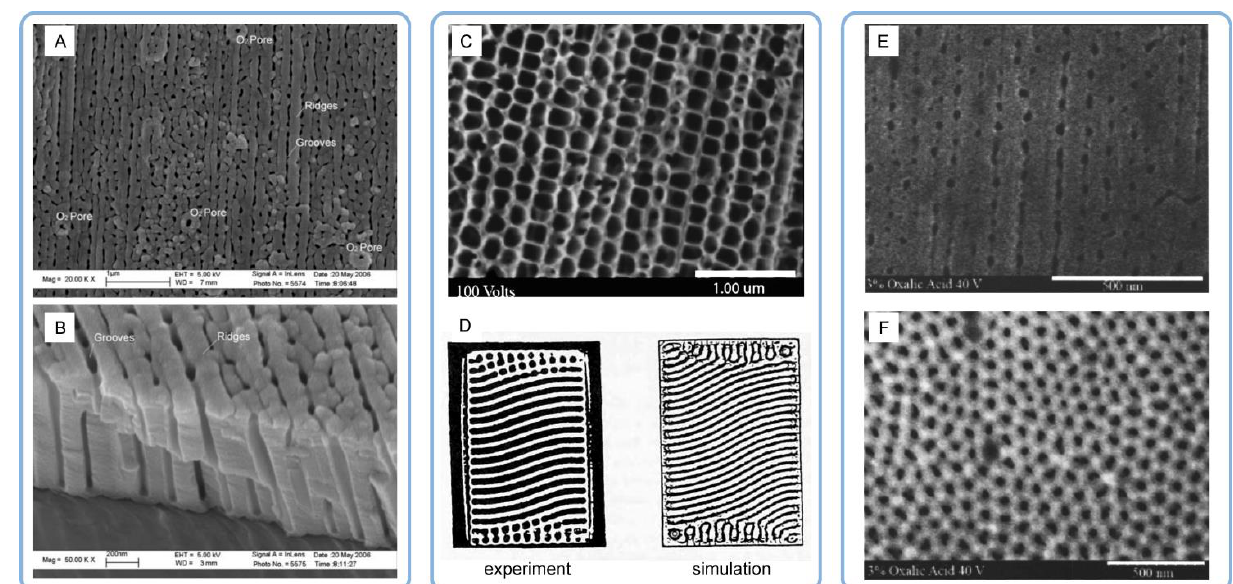
Figure 36. ( A , B ) Pores in PAA organized in parallel rows instead of the habitual hexagonal arrangement (the synthesis was performed in a 6 wt % H 3 PO 4 solution in ethylene glycol under galvanostatic conditions; see Ref. [156]); ( C ) Nearly square PAA cells packed in rows obtained from 5% H 3 PO 4 at 100 V (Ref. [158]); ( D ) A similar macroscopic pattern observed during a thermal Rayleigh–Bénard convection experiment performed in a container with unequal side lengths (two images correspond to a photograph and a numerical simulation; see Ref. [153]); ( E , F ) The difference in pore arrangement obtained after a single-step ( E ) and after a two-step ( F ) anodizing process using 3% H 2 C 2 O 4 solution at 40 V (Ref. [161]). Reproduced with permissions. Copyrights 2008 Springer, 2007 AIP Publishing, 1998 World Scientific Pub- lishing.